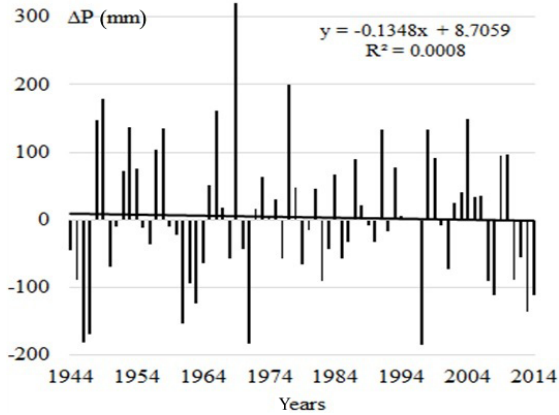
Figure 8. Deviation of annual precipitation from the long-term av- erage (1944–2016) and trend for the Khorog meteorological station.